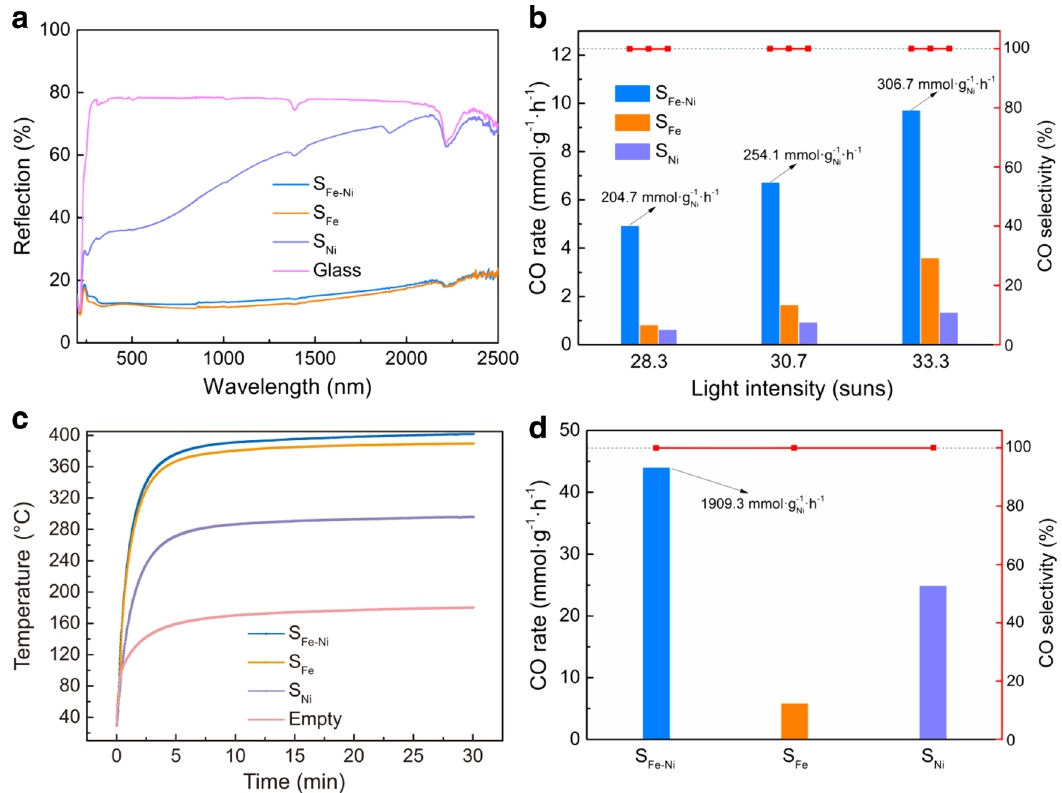
Fig. 4 | Enhanced photothermal performance. a Diffuse re fl ectance spectra of differentcatalysts. b COproductionratesofdifferentsamplesilluminatedwithaXe arc lampsupplemented with a light concentrator in the fl ow reactor.The power of thelampwassettobe190,200,and210W,correspondingtothelightintensitiesof 28.3, 30.7, and 33.3 suns, respectively. Three data points were collected to obtain the average CO rate after 10min illumination for each sample. c Surface tem- peraturepro fi lesofdifferentsamplesilluminatedwithconcentratedlightfromaXe arclamp.Thepowerofthelampwassettobe210W.Theequilibriumtemperatures